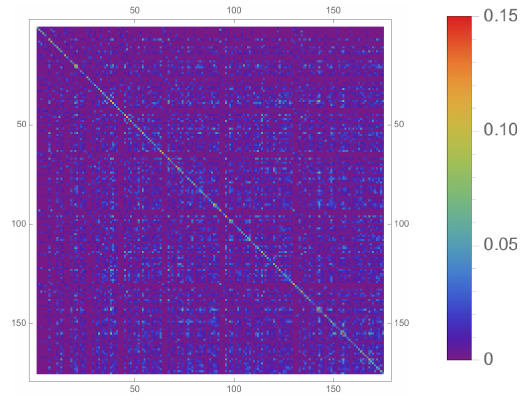
Figure 4 . An array plot of the matrix e − S | M αβ | for N = 10 , q = 3 , k = 3 , J = 1 SYK and time t = 50 . We note that most of the off-diagonal elements are smaller than e − S , while many diagonal matrix elements are also O ( e − S ) at such late